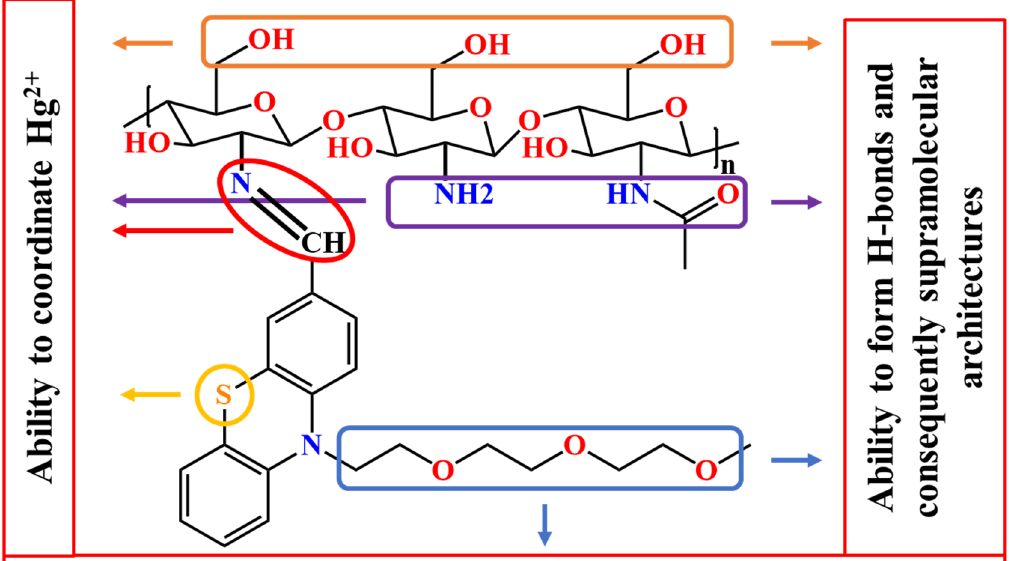
Scheme 1. Pictorial representation of the rational design of the studied